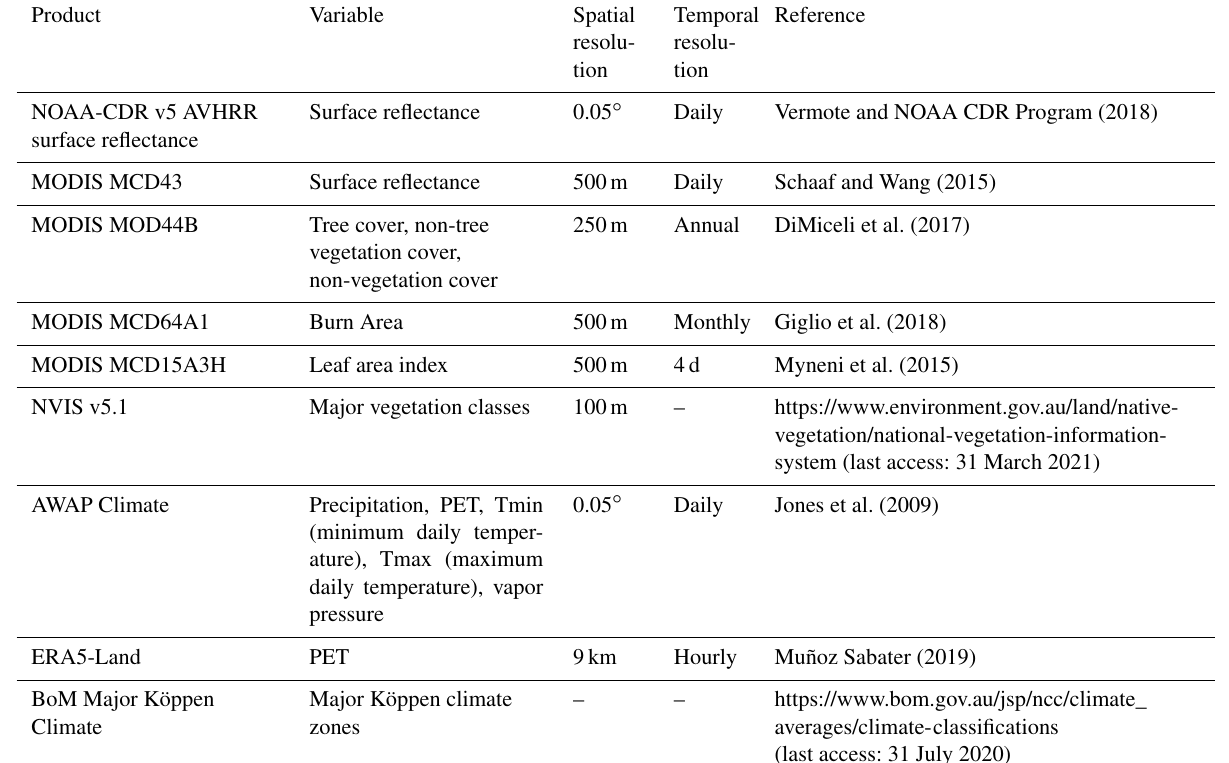
Table A1. Data products